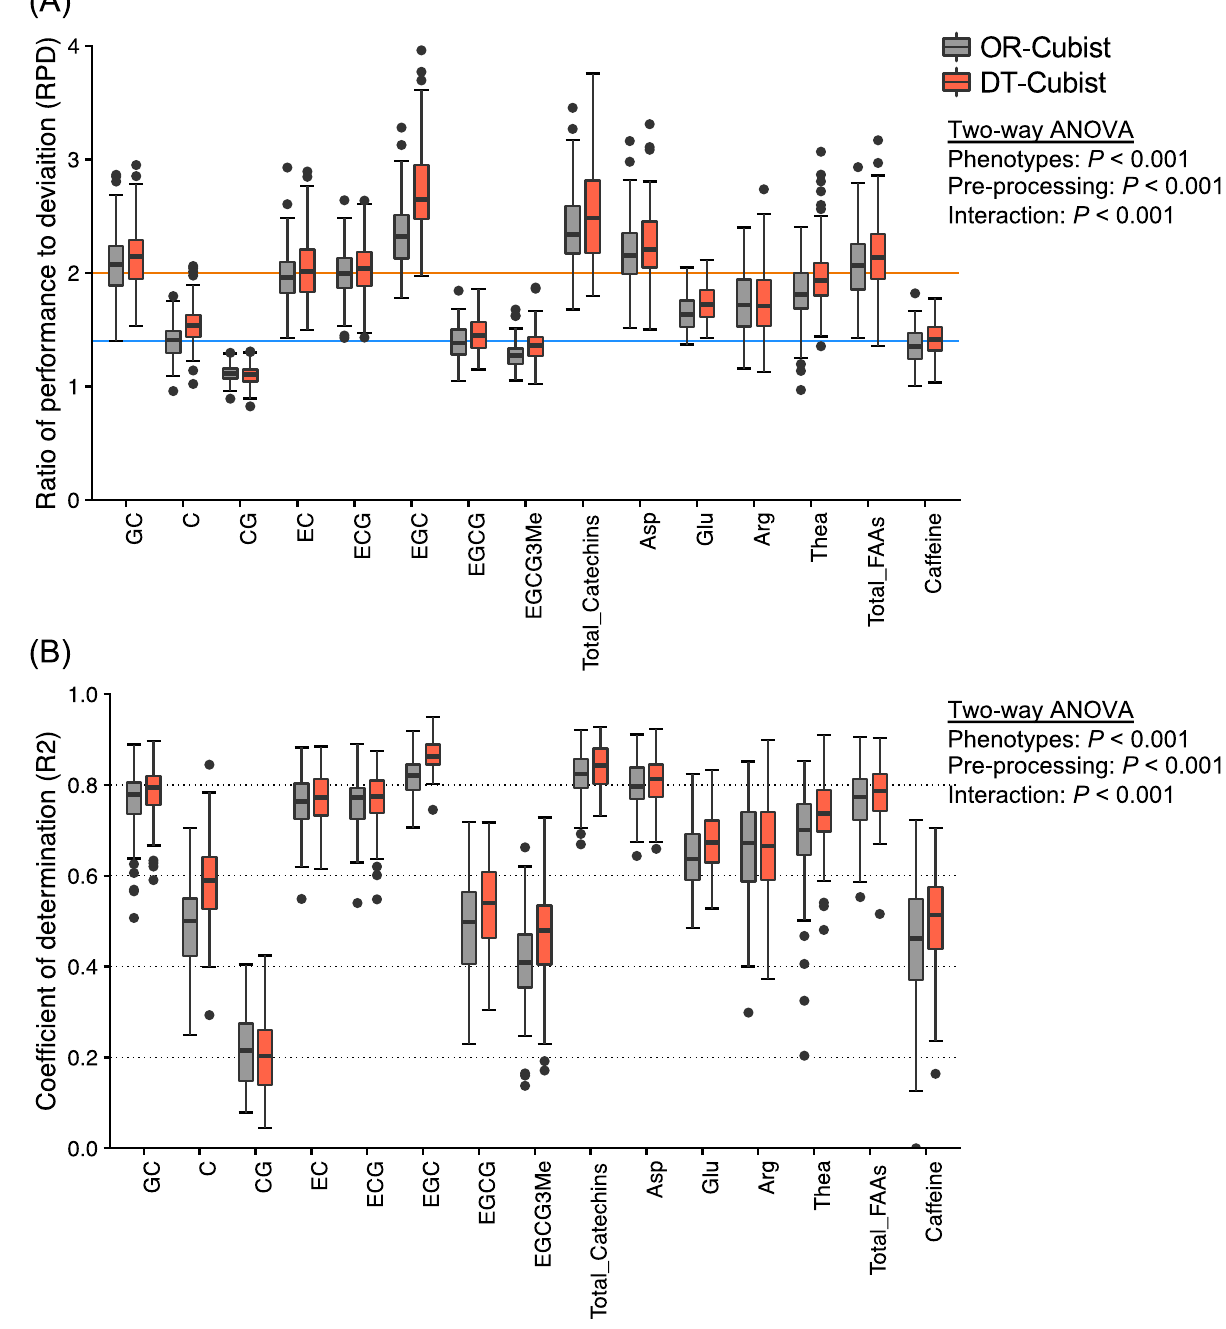
Figure 3. Model performance and robustness based on OR-Cubist and DT-Cubist for tea quality-related metabolites. The ratio of performance to deviation (RPD, A ) and coefficient of determination (R 2 , B ) were applied to evaluate the accuracy of each model. A stratified sampling approach for modelling was repeated 100 times to obtain robust results. Figure are plots of the RPD and R 2 values in each repeat. Orange and blue lines indicate RPD values of 1.4 and 2.0, respectively, as accuracy thresholds. Statistical tests for significant differences by two-way ANOVA are shown on the right side of the Figure. Figures were visualized by the R package “ggplot2” ver.